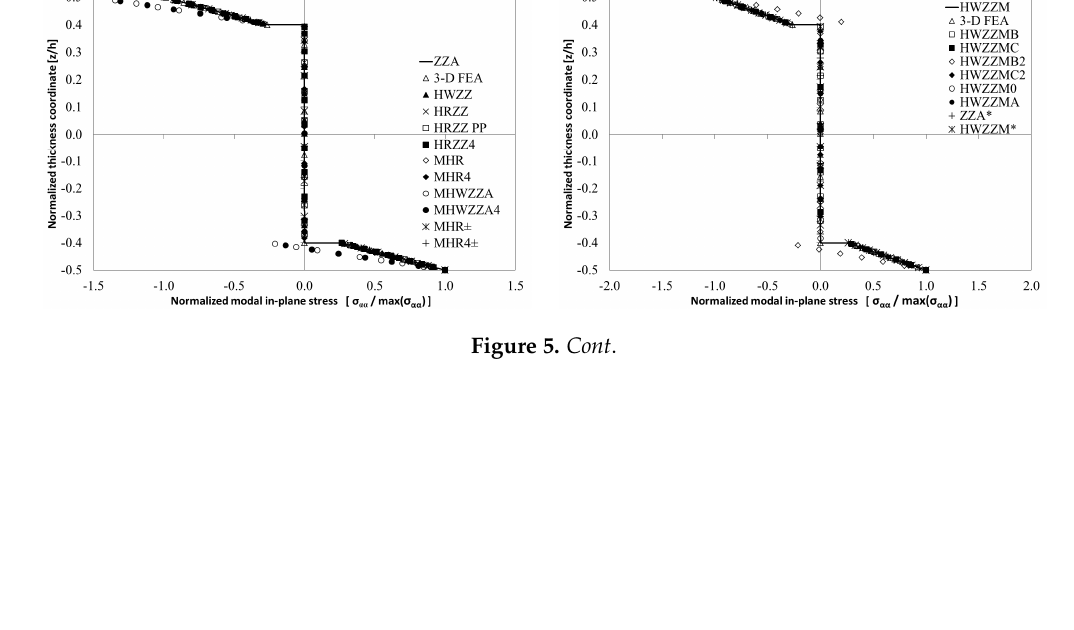
Figure 4. Case b3: Normalized modal displacements and stresses of a simply supported sandwich plate in cylindrical bending ( L x/ h = 10).